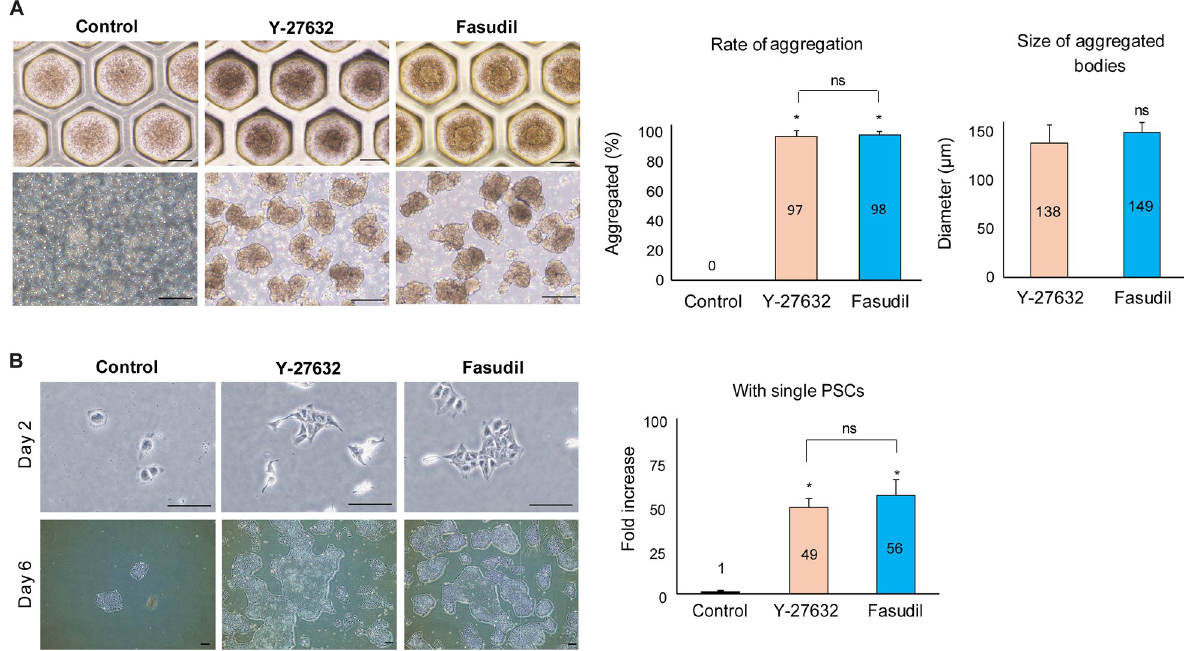
Fig 6. Other applications of fasudil. A: Supportive effect of fasudil on hES3 survival and growth in suspension culture. The fasudil-treated groups and Y-27632-treated groups were similar in the rate of formation of cell aggregates and their size; the control cells did not form aggregates. Scale bar = 200 μ m ( � : p < 0.05, 2 biological replicates, 7 technical replicates). B: Seven-day cultures of single hES3 cells on vitronectin-coated culture plates in the presence of 10 μ M Y-27632 or fasudil. Scale Bar = 200 μ m. The growth of hPSCs was faster with Y-27632 or fasudil than in the untreated control ( � : p < 0.05, 3 technical replicates). hES: human embryonic stem cell, hPSC: human pluripotent stem cell.